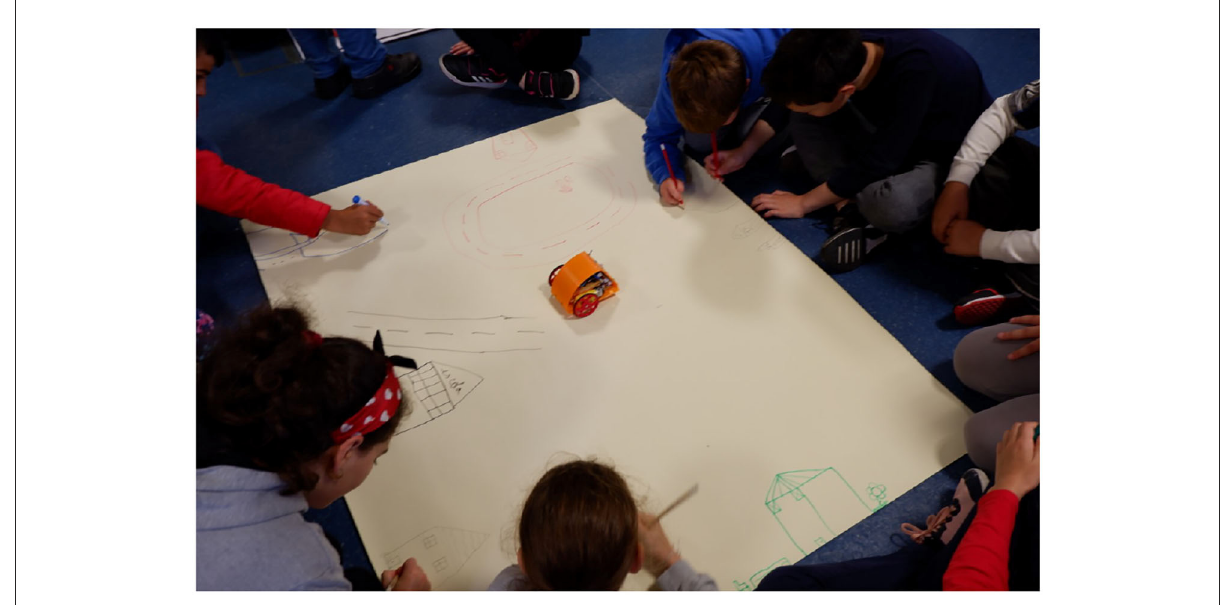
FIGURE4 First testing of Azbot-1C in a free activity at the Rabo de Peixe elementary